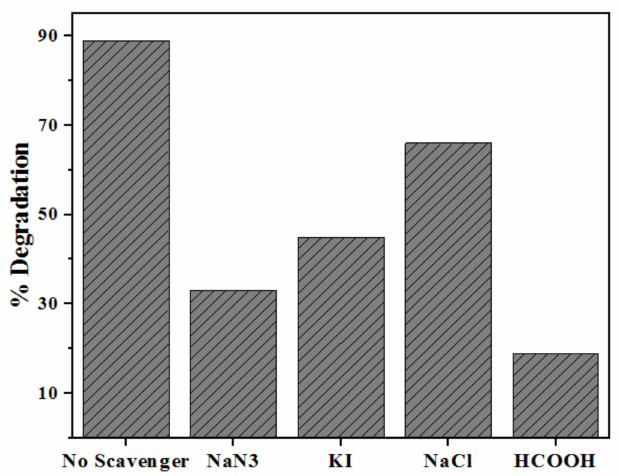
Figure 19. Mn 2+ :ZnS Qds based sonophotocatalytic degradation of SDB with different scavengers.